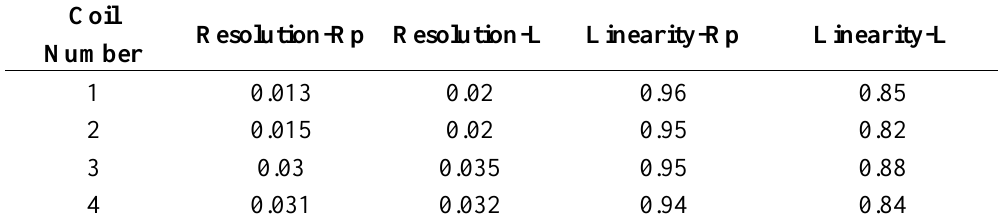
Table 3. Resolution and Linearity of Rp and L measuring a target at 10 mm